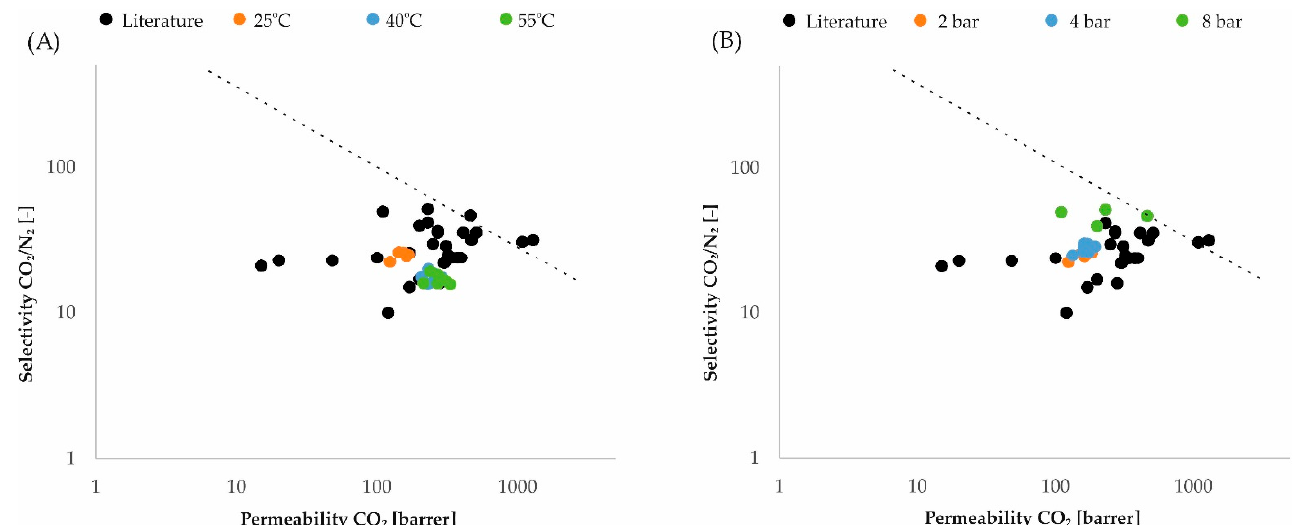
Figure 11. Comparison of results in the literature with the authors’ results: ( A ) temperature effect at constant pressure 1 bar; ( B ) pressure effect at constant temperature 25°C.